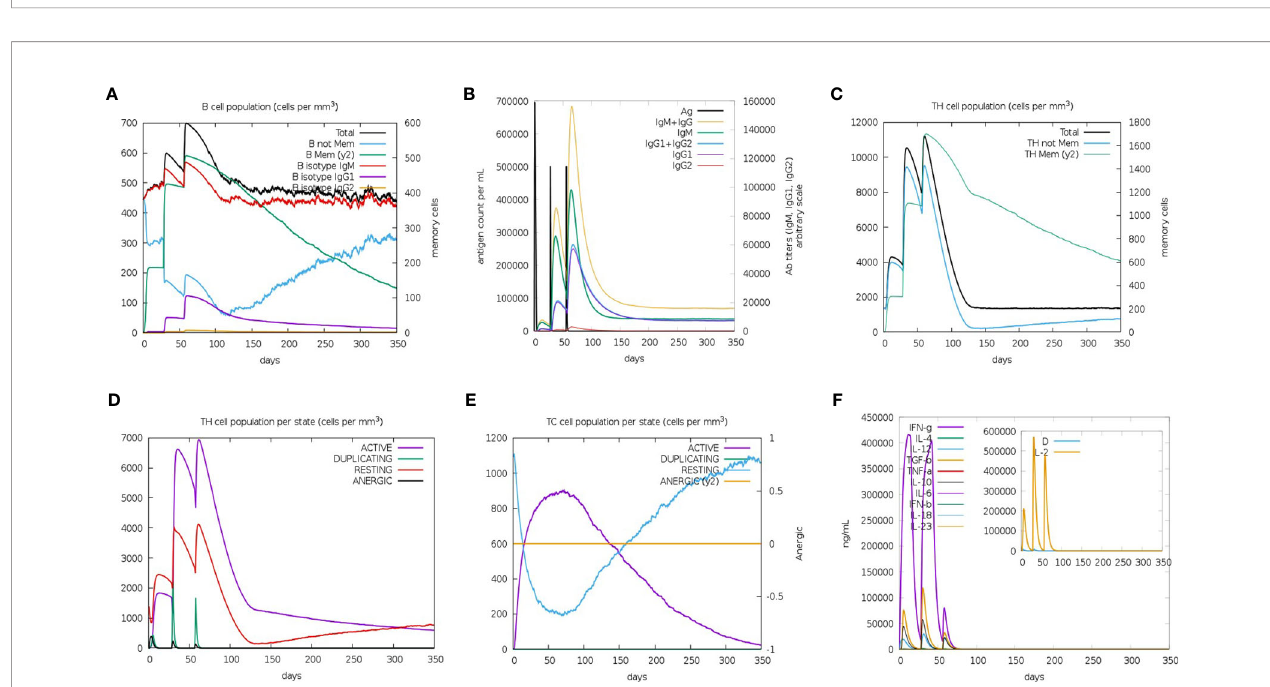
FIGURE 13 | The immune simulated response spectrum. (A) The B-cell populations that could produce antibodies of various subtypes after vaccination. (B) The production of antibodies that represented the proliferation of the immune response after vaccination, and the various subtypes of immunoglobulins were shown in different colors. (C) The generation of memory and non-memory HTL populations after vaccination. (D) The HTL populations in various states. (E) The CTL populations in various states. (F) The cytokine pro fi le showed the production of various cytokines after